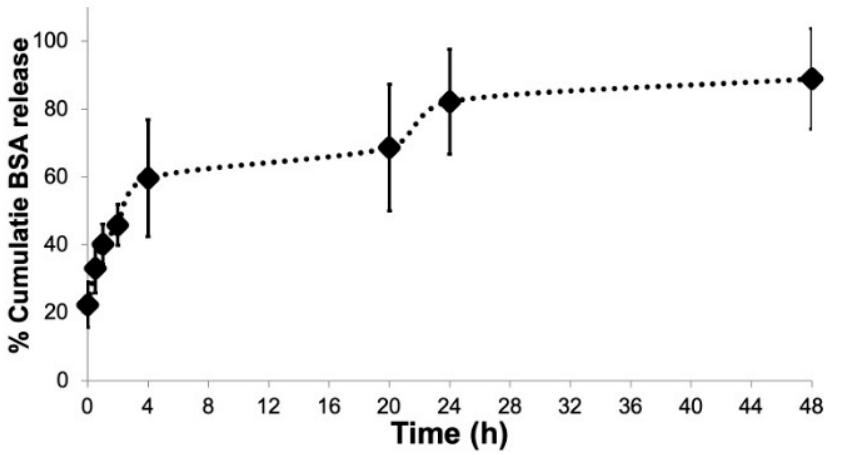
Table 2. In vitro kinetic model parameters of BSA released from cationic CHL NPs/NCMPs. Formulation